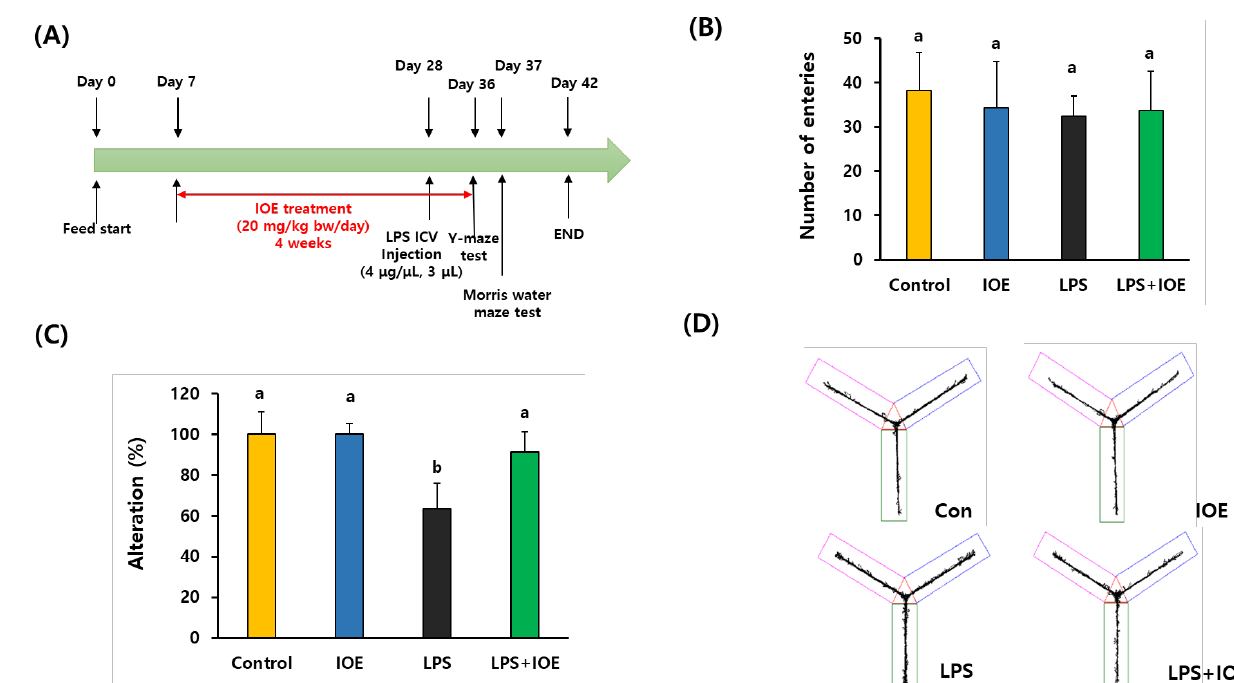
Figure 1. IOE attenuated the LPS-mediated spatial memory impairment in mice. IOE was orally administered to mice for 4 weeks and then LPS was ICV injected to mice ( n = 7) ( A ). LPS-induced cognitive impairment was investigated by using a Y-maze test. The number of entries ( B ) alteration (%) ( C ) and path tracing ( D ) of each mice group were estimated by using a SMART 3.0 video tracking system. Each data value is expressed as the mean ± SD. Different letters (a,b) indicate the significant differences between groups ( p < 0.05). Each value is assigned as a and b sequentially from the highest value.